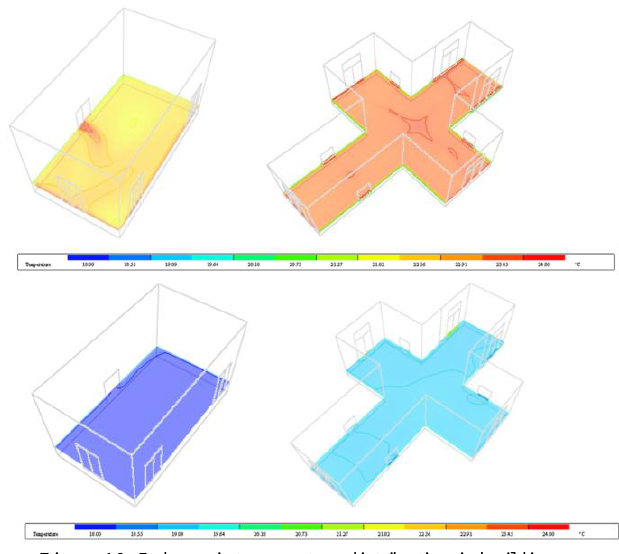
Figure 10. Indoor air temperature distribution in building simulation, in Summer (2 nd July 2016) Tribunale D’Amore (top- left picture) and Croce Centrale (top-right picture) and in Winter (29th December 2016) Tribunale D’Amore (bottom-left picture) and Croce Centrale (bottom-right